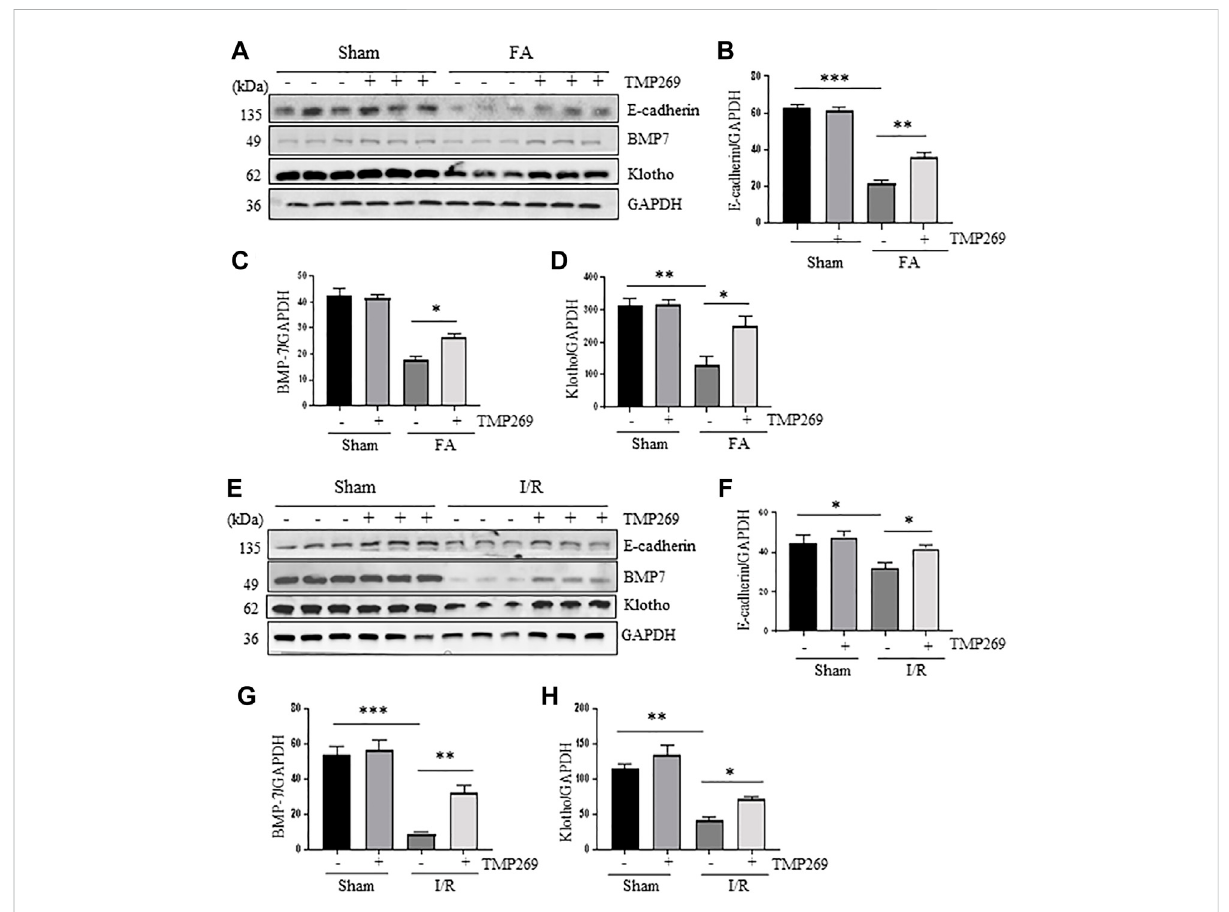
FIGURE 6 Administration of TMP269 preserves expression of E-cadherin, BMP7 and Klotho in the kidney following FA and I/R injury (A,E) Kidneys were injured by FA or IR, respectively, and tissue lysates were subjected to immunoblot analysis with speci fi c antibodies against E-cadherin, BMP7, Klotho and GAPDH. Representative immunoblots are three samples in each group. Expression levels of E-cadherin (B,F) , BMP-7 (C,G) , or Klotho (D,H) were quanti fi ed by densitometry and normalized with GAPDH. Data are means ± SD ( n = 3). * < 0.05; ** p < 0.01; *** p <